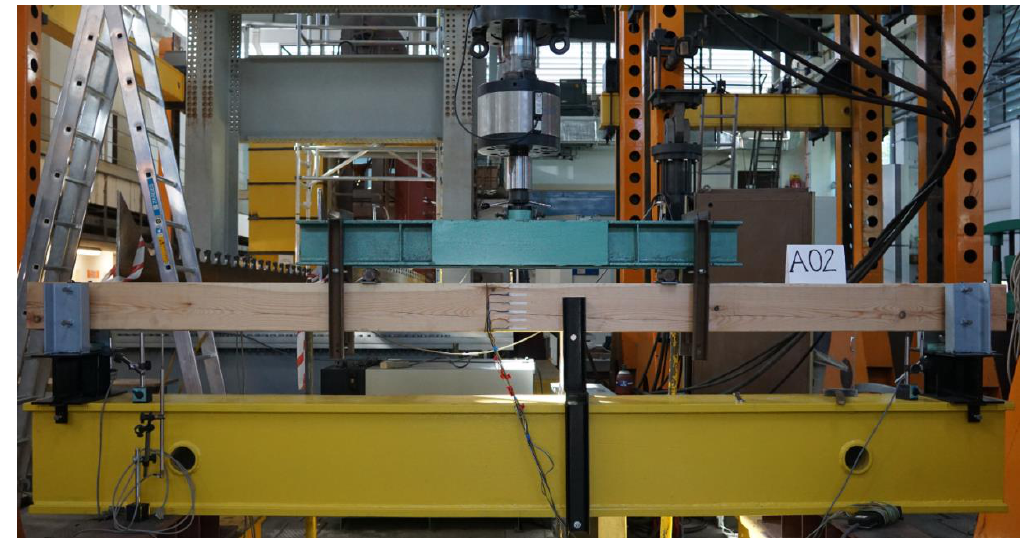
Figure 14. View of experimental stand for testing with an example beam.